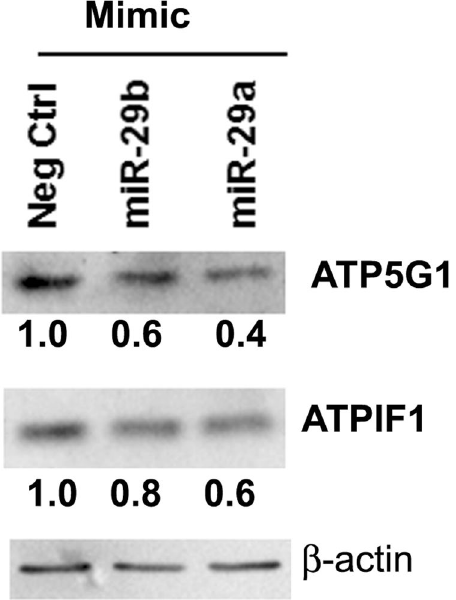
Figure 5. miR-29-b-1/a downregulate ATP5G1 and ATPIF1 protein expression in LCC9 breast cancer cells. LCC9 cells were grown in hormonally depleted medium and transfected with mimic negative control (Neg Ctrl), miR-29b mimic, or miR-29a mimic for 48 h. ATP5G1 and ATPIF1 and β -actin (normalizer) was examined in WCE (10 µ g protein/lane). These images were cropped from full-length blots (Supplementary Figs 13–15). The same blot was stripped and reprobed for each protein. Values are ratios of ATP5G1/ β -actin or ATPIF1/ β -actin with the Neg Ctrl set to one. This blot if from one